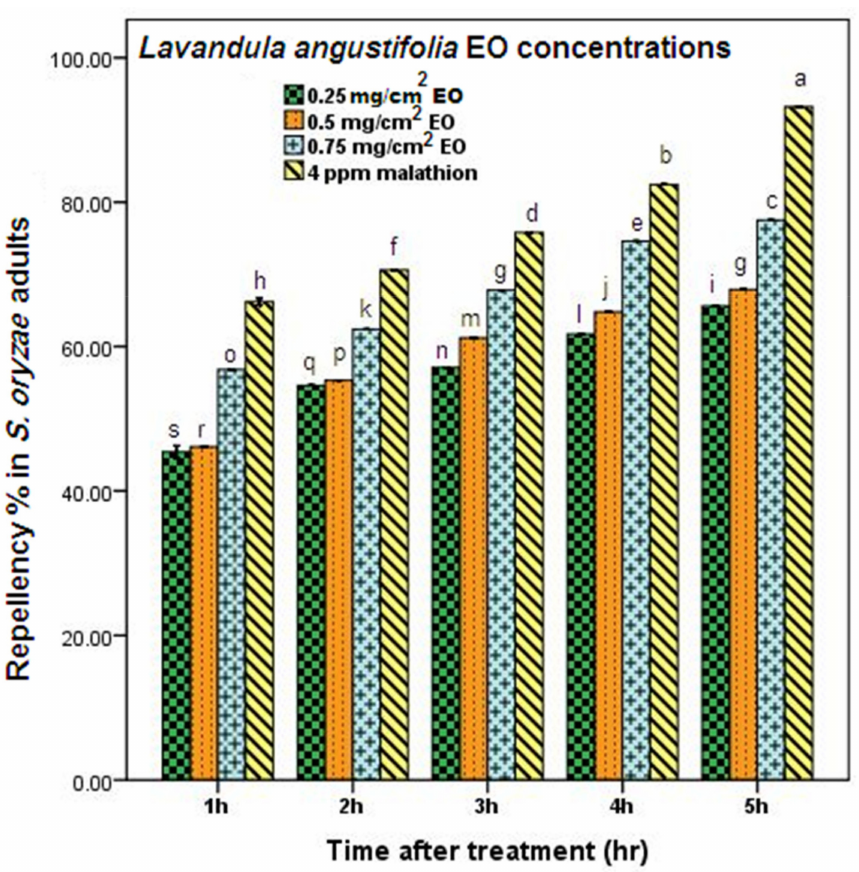
Figure 6. Impact of different concentrations (0.25, 0.5, and 0.75 mg/cm 2 ) from L. angustifolia EOs and on repellent % of S. oryzae adults at 1, 2, 3, 4, and 5 h exposure times (mean ± SD) compared with standard chemical pesticide (4 ppm malathion). Different letters indicate significant differences between different treatments at p < 0.05; LSD = 0.